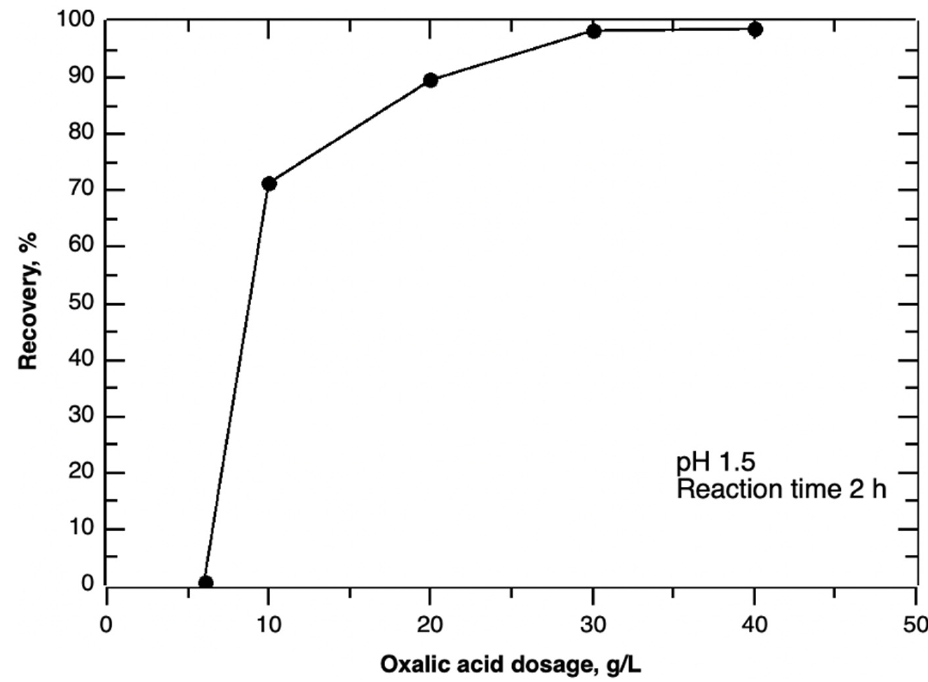
Figure 5. Effect of oxalic acid dosage on the REEs recovery at a fixed pH of 1.5 and reaction time of 2 h.